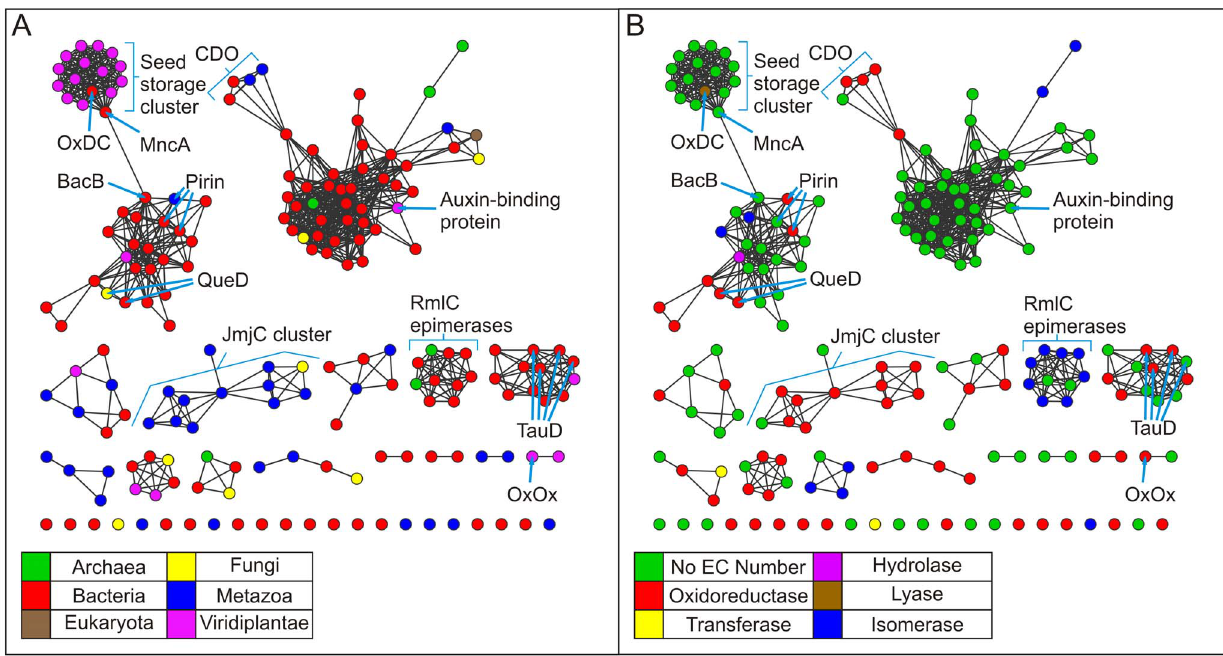
Figure 5. Structure similarity networks colored by species and function. This is the same network as in 3B but colored according to A. species and B. function.